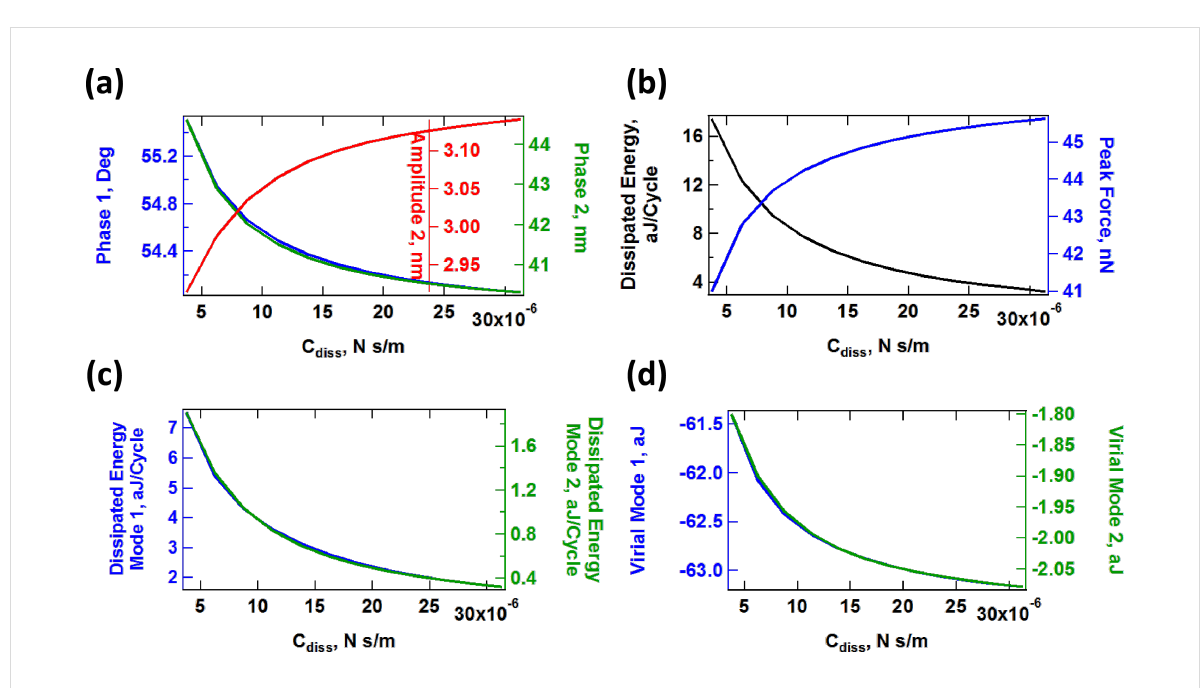
Figure 13: Effect of the SLS parameter C diss on tip–sample interactions and cantilever response. (a) First and second mode phase, and second mode amplitude; (b) dissipated energy calculated from the hysteresis loop of the tip–sample force trajectory and peak impact force; (c) calculated dissipated energy from Equation 5 for the first and second eigenmodes; (d) virial for the first and second eigenmodes. Note that the peak impact force is the largest repulsive force observed over fifteen tip–sample impacts (successive impacts differ, as illustrated in Figure 7c). The parameters other than C diss are the same used to construct Figure 10. The axes are color coded in all